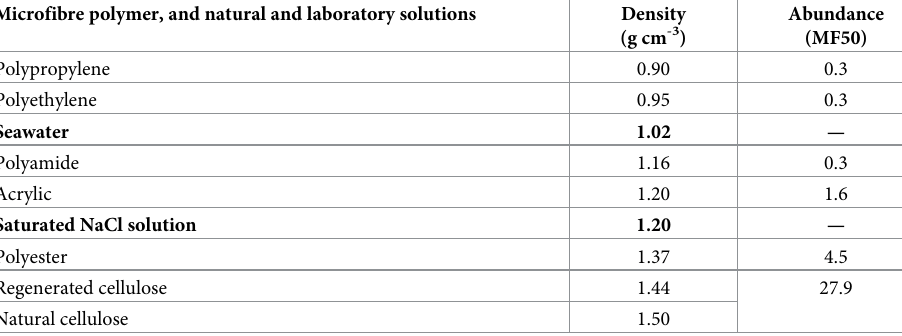
Table 1. Densities and abundances of microfibres. Microfibre polymer, and natural and laboratory solutions Density Abundance (g cm -3 ) (MF50) Polypropylene 0.90 0.3 Polyethylene 0.95 0.3 Seawater 1.02 — Polyamide 1.16 0.3 Acrylic 1.20 1.6 Saturated NaCl solution 1.20 — Polyester 1.37 4.5 Regenerated cellulose 1.44 27.9 Natural cellulose 1.50 Densities of the different types of polymers extracted from surface sediment layers of the southern European seas, along with those of seawater and the hypersaline (saturated) solution used for microfibre extraction, and abundance of each polymer in the analysed sediments. Fibres denser than the saturated NaCl solution were recovered because they attach to raising air bubbles formed when shaking the solution in the laboratory (see Methods section). MF50: microfibres in 50 ml of